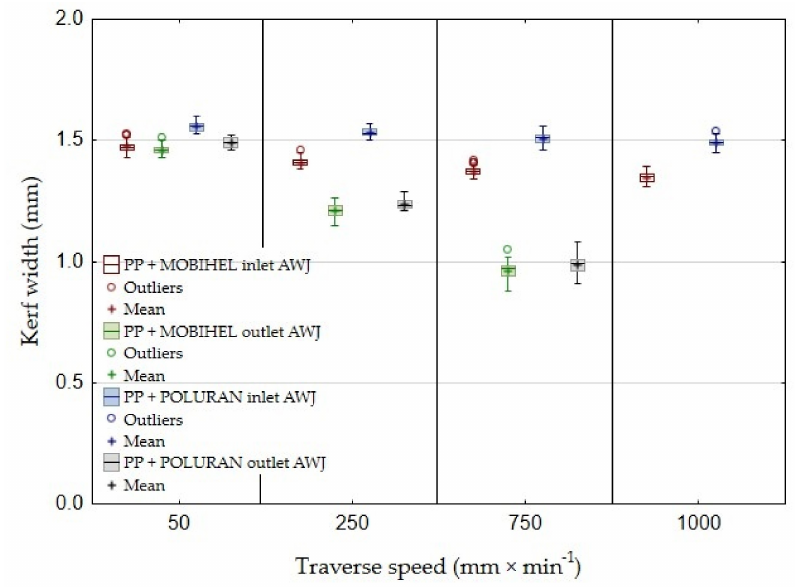
Figure 16. Comparison of the width of the cutting gaps created by AWJ technology on the inlet and outlet side of the waterjet in PP +POLURAN and PP +